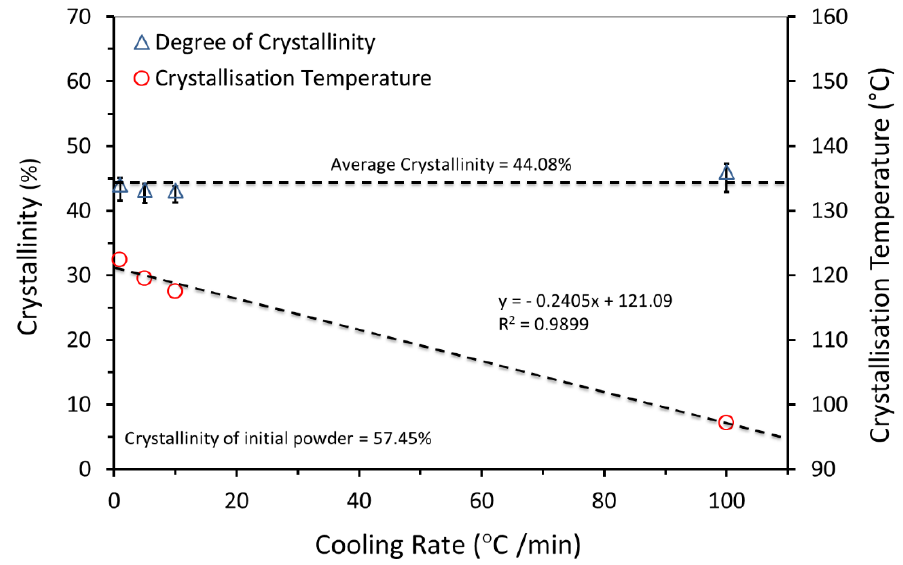
Figure 10. Influence of cooling rate on the crystallisation of the UHMWPE.